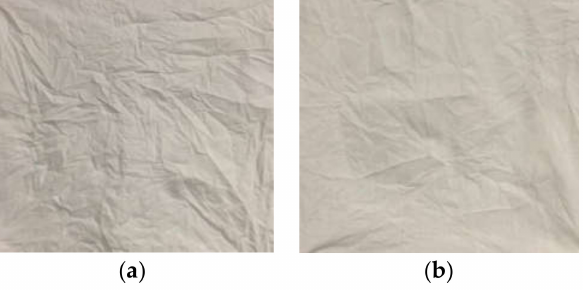
Figure 1. Fabric appearance: untreated ( a ) and resin-treated ( b